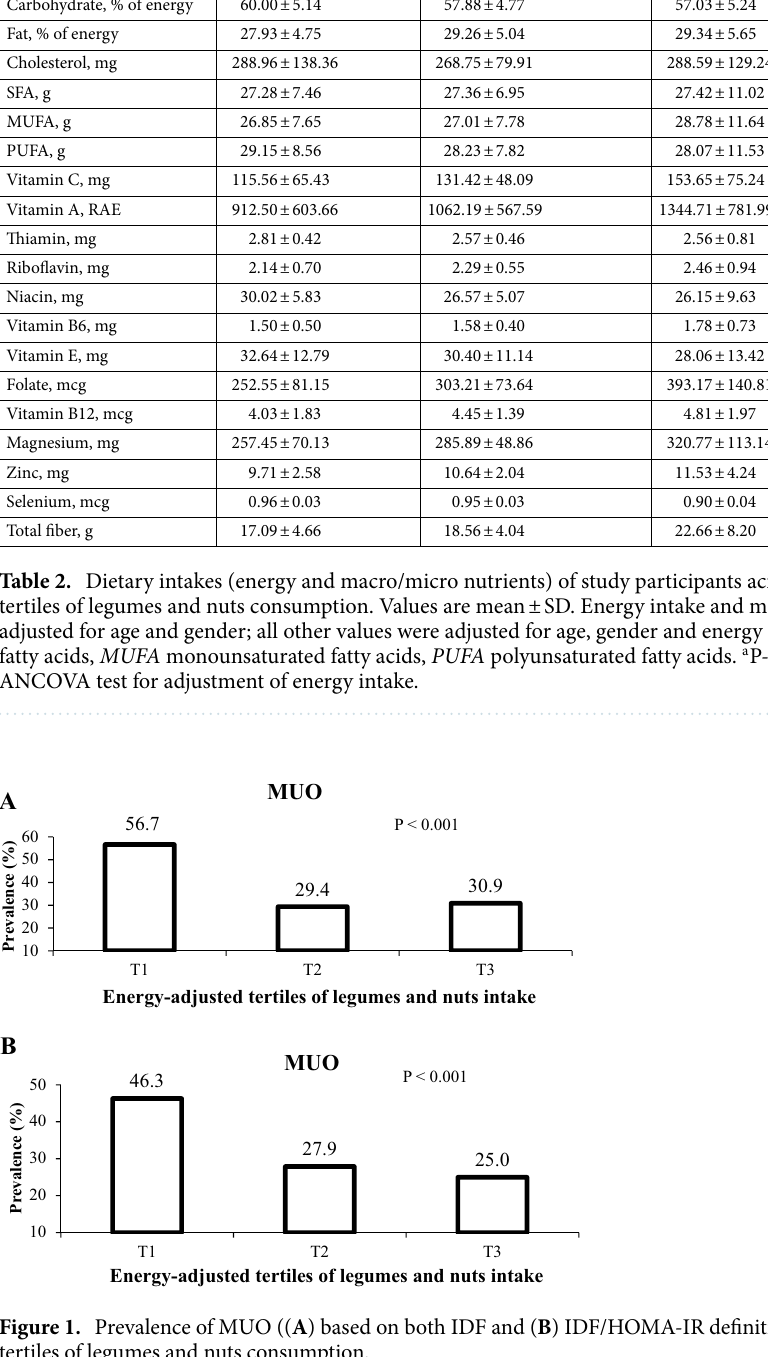
Multivariate adjusted odds ratio (OR) and 95% confidence interval (CI) for MUO components across energy- adjusted tertiles of legumes and nuts consumption are reported in Table 4 . In crude model, higher legume and nut consumption was significantly related to lower odds of hyperglycemia (OR = 0.29, 95% CI 0.14–0.60), low HDL-c (OR = 0.46, 95% CI 0.23–0.93) and insulin resistance (OR = 0.20, 95% CI 0.09–0.47). After adjustment for potential cofounders, only an inverse significant association was found between legumes and nuts consumption and odds of hyperglycemia (OR = 0.35, 95% CI 0.16–0.78).